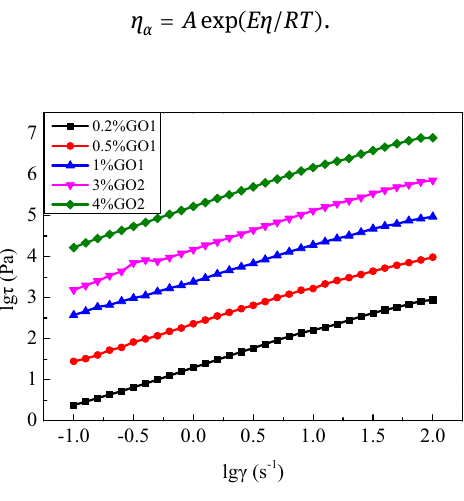
Figure 7: lg τ – lg γ curve of PAN/GO/DMSO blend solution.